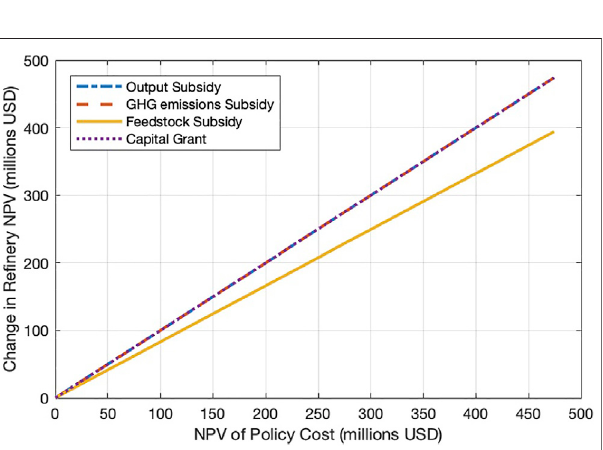
FIGURE 3 | Change in re fi nery NPV vs. total cost of policy for all pathways (lines for output subsidy, GHG emissions subsidy, and capital grant